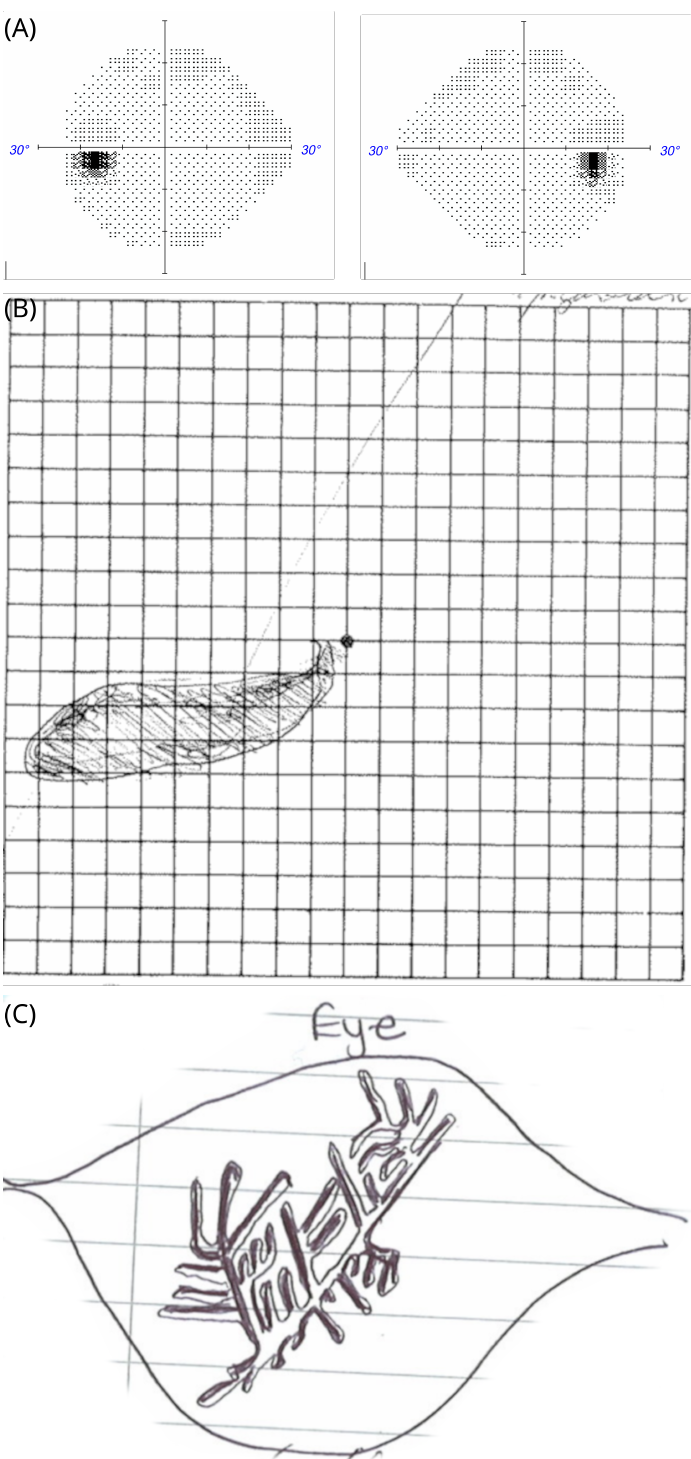
Figure 1. Tiling inside a relative scotoma in patient #1. ( A ) Automated perimetry showing the Humphrey SITA standard protocol with a white size III stimulus. ( B ) relative macular arcuate scotoma on the Amsler chart. She can see the grid lines through the scotoma. ( C ) Tiling pattern as sketched by the patient within the scotoma of her left eye on a white piece of paper with thin greyish lines. She described the tiling pattern as constantly moving lines. The colour of the lines was described “yellowish” against different